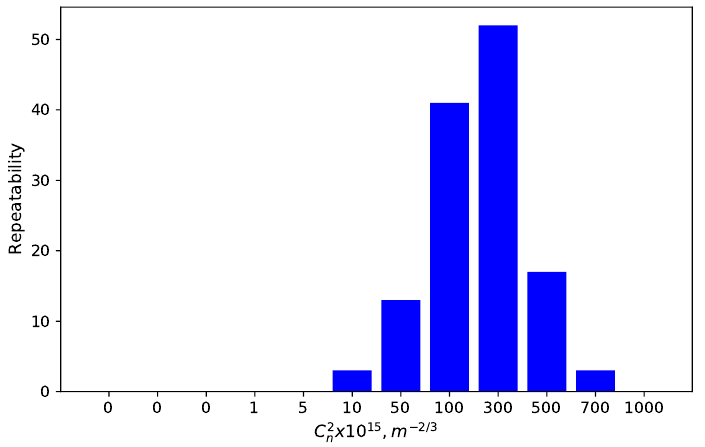
Figure 4. The repeatability of the optical turbulence at the Baykal astrophysical observatory site in autumn.